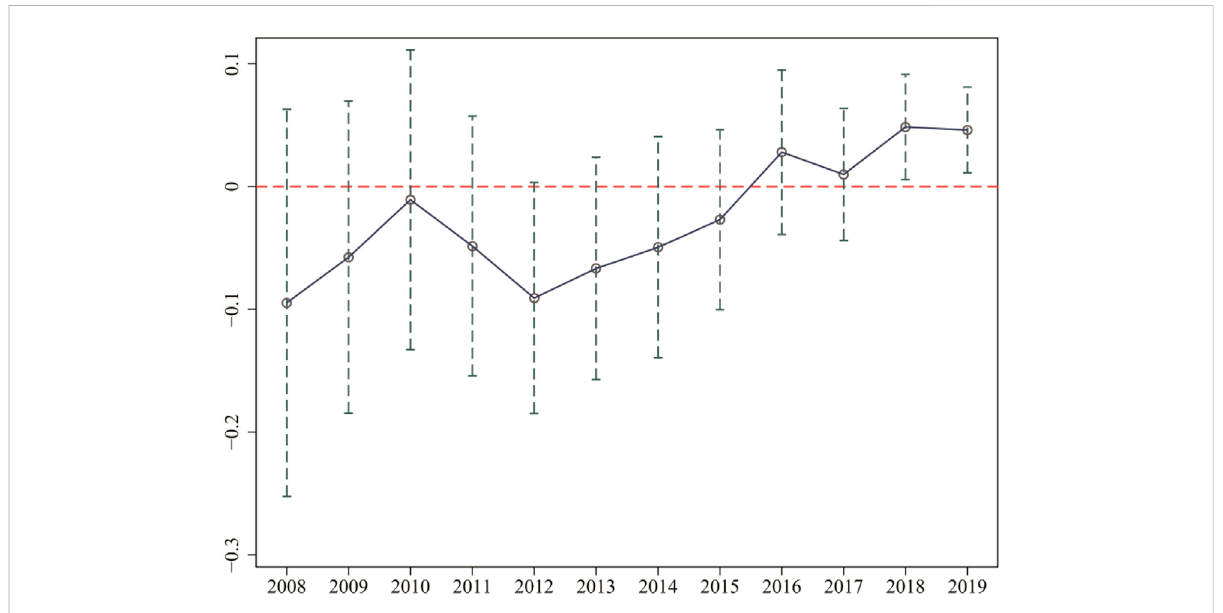
FIGURE 1 Parallel trend test (PS: The fi gure is drawn according to the value and the con fi dence interval of the coef fi cient λ m estimated by the event study model).